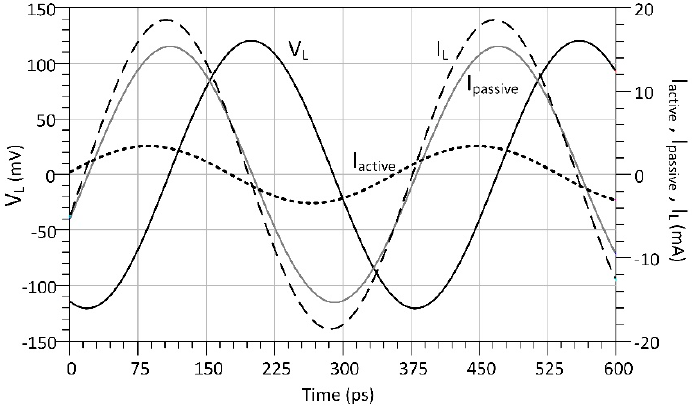
Figure 15. Simulated voltage and current at the input of the resonating cell (see Figure 10b).